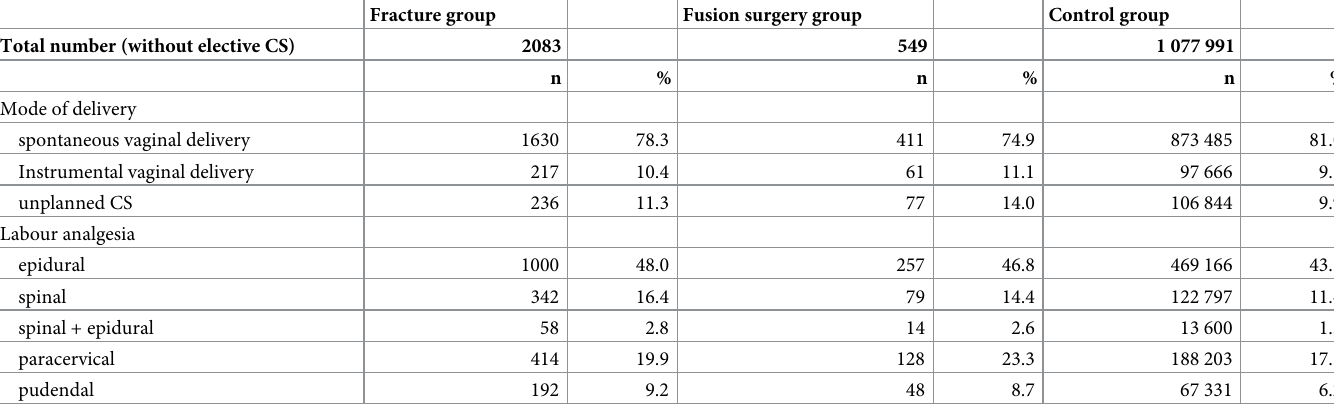
Table 3. Proportions of obstetric variables in attempted vaginal deliveries (without elective CS) of the fracture patient groups and the control group. Elective CS was the intended mode of delivery in 218 (9.5%) of all deliveries in fracture group, 83 (13.1%) in fusion surgery for other reasons group and 76 478 (6.6%) in control group.